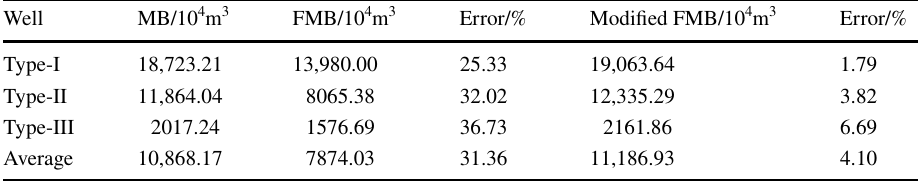
(Table.6, Fig. 16).②The reserve of Type-II is 1.18 × 10 8 m 3 . The error of FMB and the error of modified FMB are 32.02% and 3.82%.③The reserve of Type-III is 0.20 × 10 8 m 3 , with